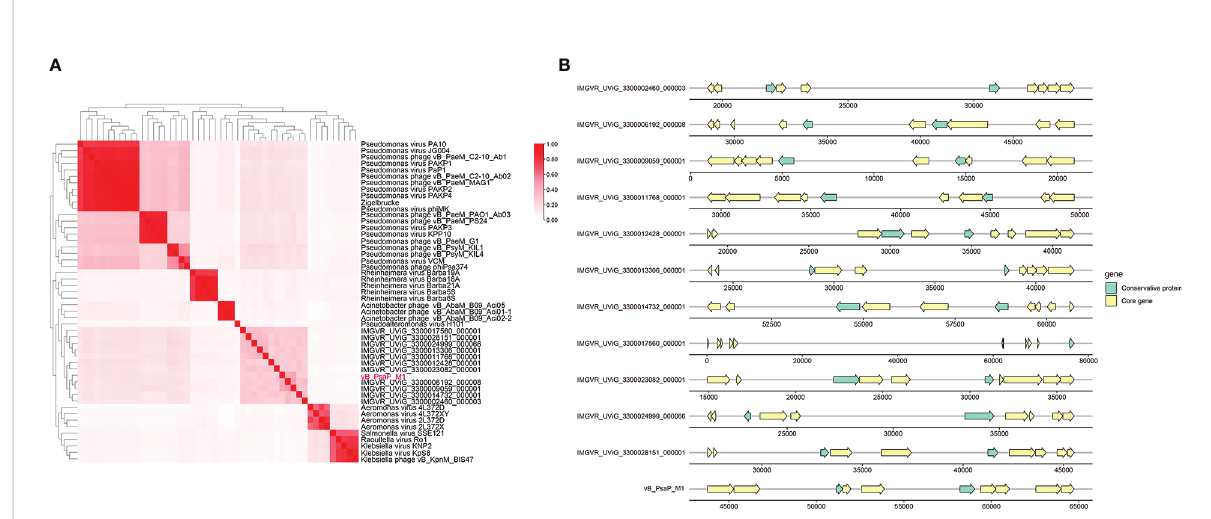
FIGURE 7 (A) Heat map of gene sharing rate between vB_PsaP_M1 and other phages. The sharing rate is displayed by color depth. (B) The gene map of VC_61. Core genomes are represented by yellow arrows and the conservative protein are represented by green